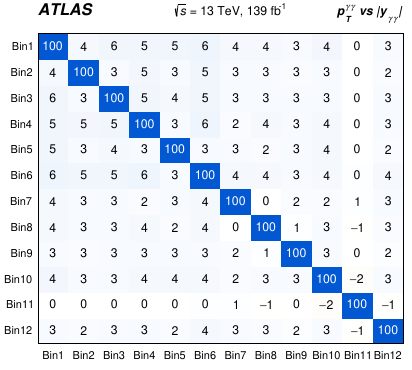
vs | y . The order of γγ | T